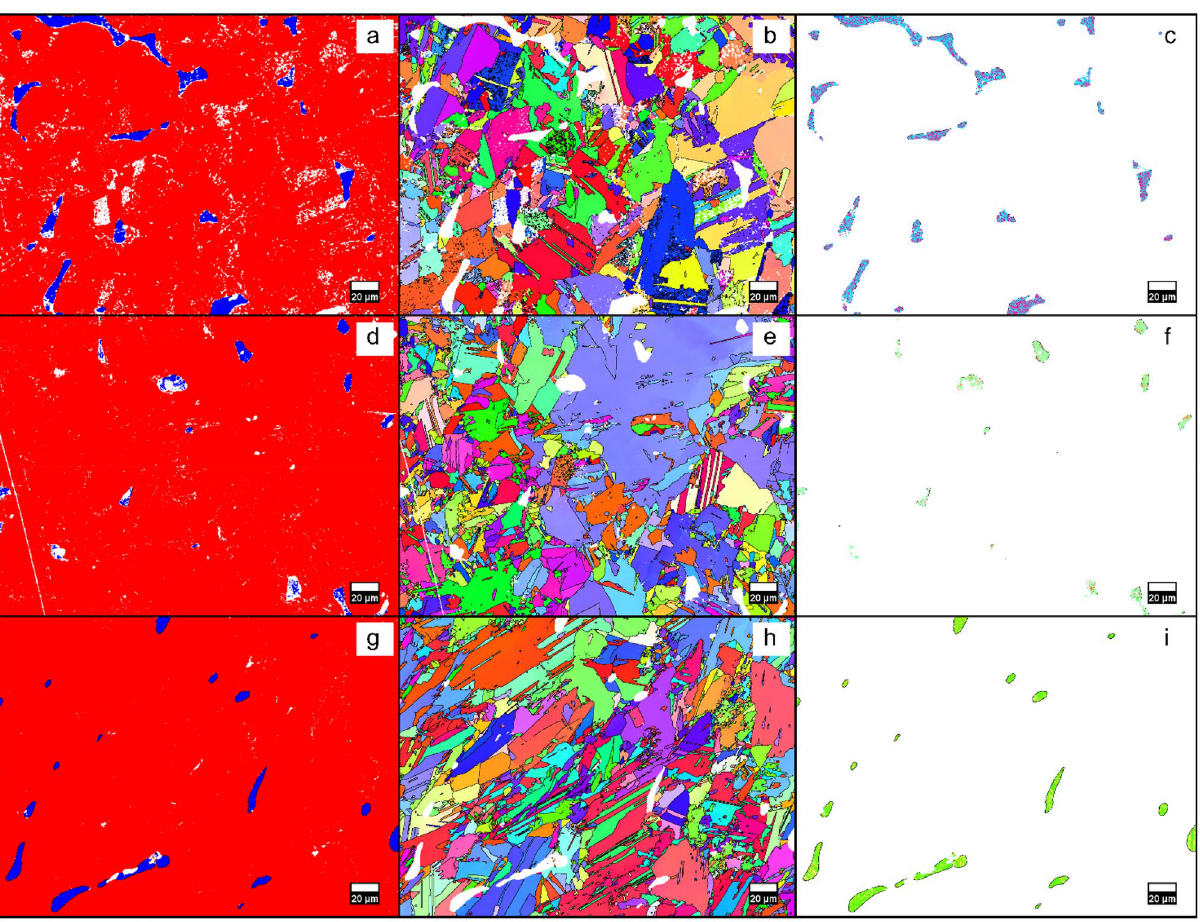
Figure 3. Phase maps with the τ-phase in red and the γ 2 -phase in blue obtained from EBSD measurements for the